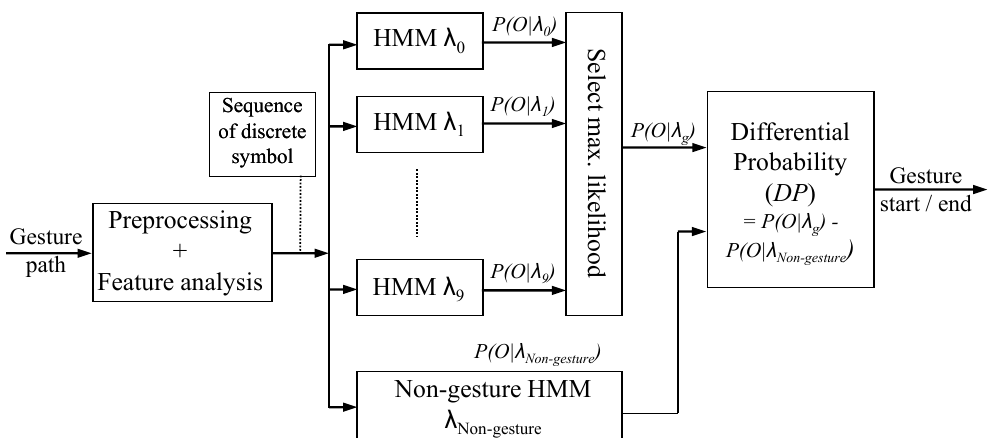
Figure 10. Main structure for hand gesture spotting using the DP